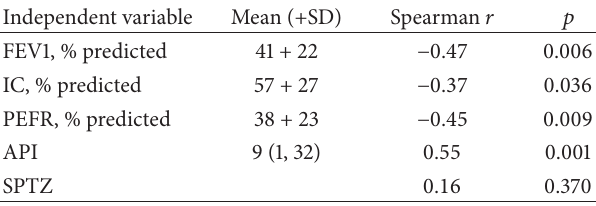
Table 1: Bivariate analysis using Spearman correlation to measure association of dyspnea (dependent variable) with lung function and psychometric data obtained in the emergency department (independent variables) obtained simultaneously.